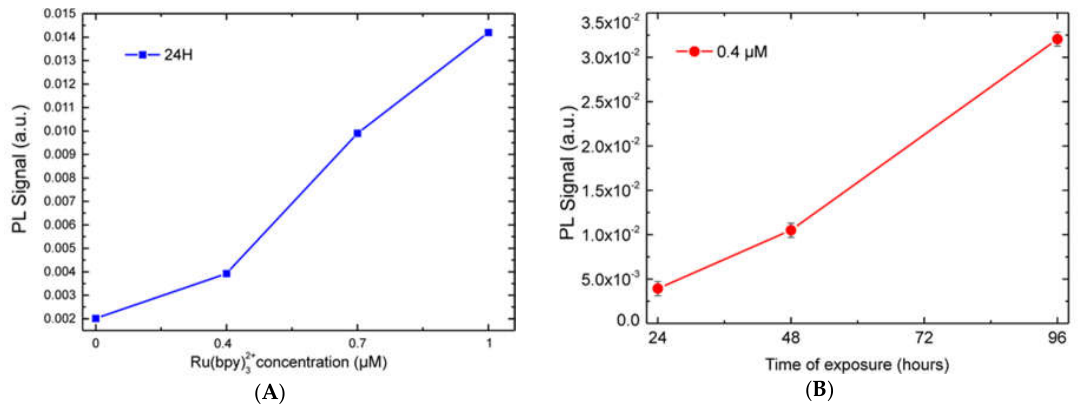
Figure 5. Fluorescence emission (Photoluminescence) trend of HDF cells labeled with Ru(bpy) 32+ : increase of fluorescence signal with ( A ) fluorophore concentration and ( B ) time of exposure. Fluorescence was acquired with a 405 nm laser source at 50 mW power and revealed at 620–630 nm. Fluorescence values at 620–630 nm (i.e., the Ru(bpy) 32+ emission peak) were used to plot the data.